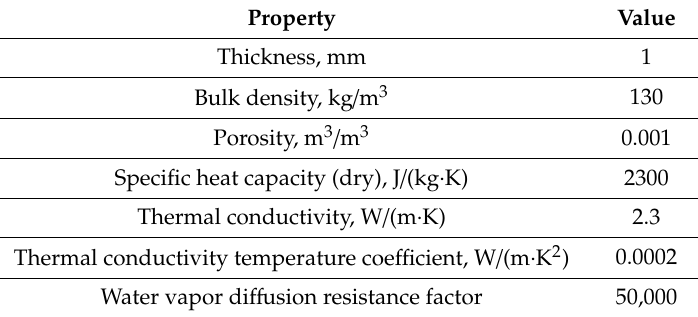
Table A25. PE property